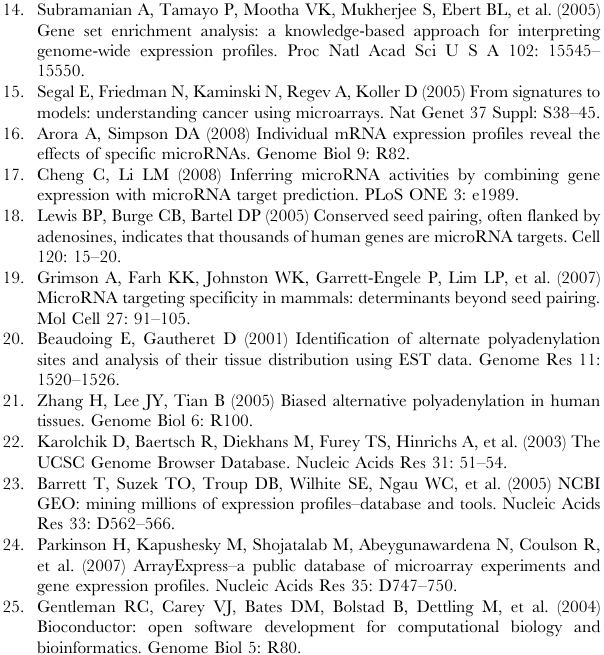
Table S5 Expression values for genes targeted by the 77 miR-